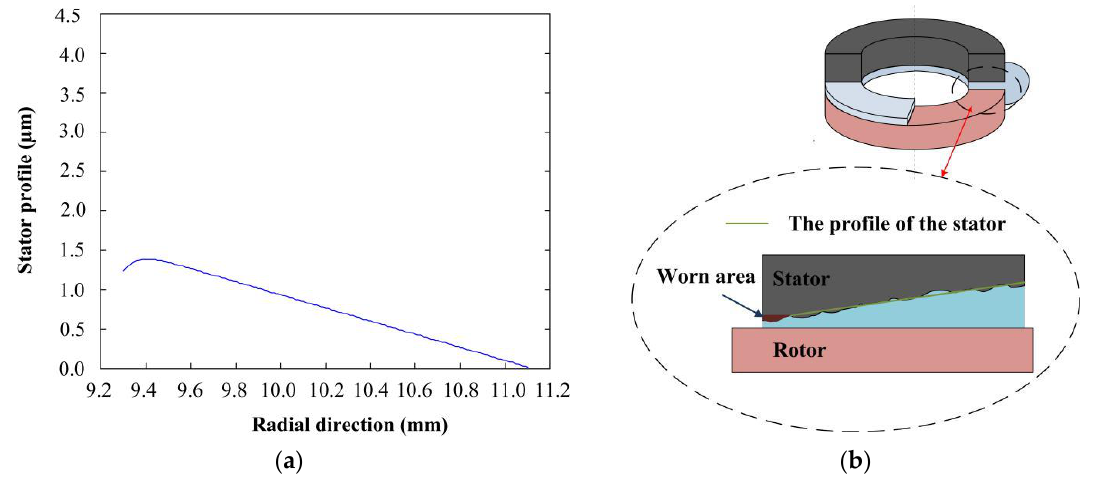
Figure 7. ( a ) Stator profile after operation; ( b ) worn area.